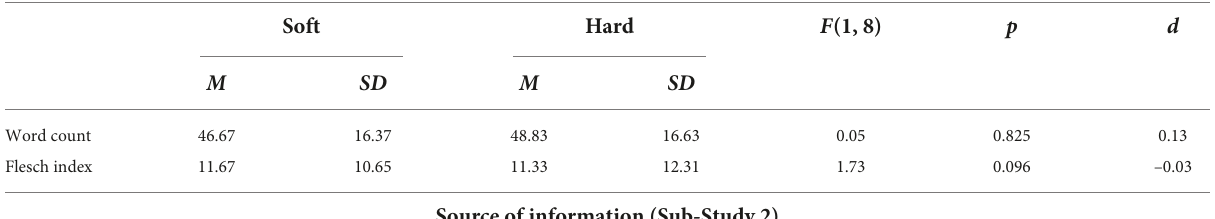
TABLE 4 Means, standard deviations, and one-way analyses of variance in length and readability of the vignettes (Sub-Study 2 and Sub-Study 3). Research method (Sub-Study